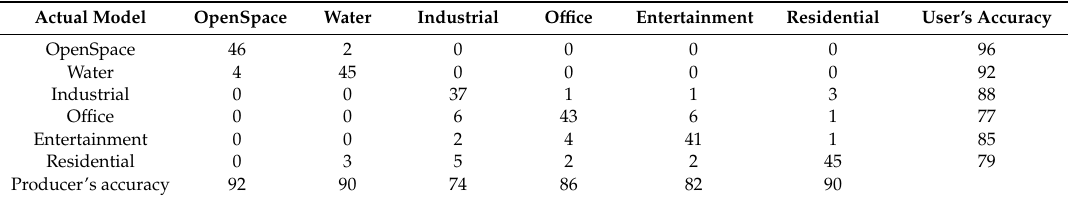
Table A6. Confusion matrix of decision tree classified map using integration of remote and social sensing (with data